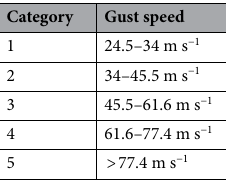
Table 1. The Australian TC wind scale as defined by wind gust speed